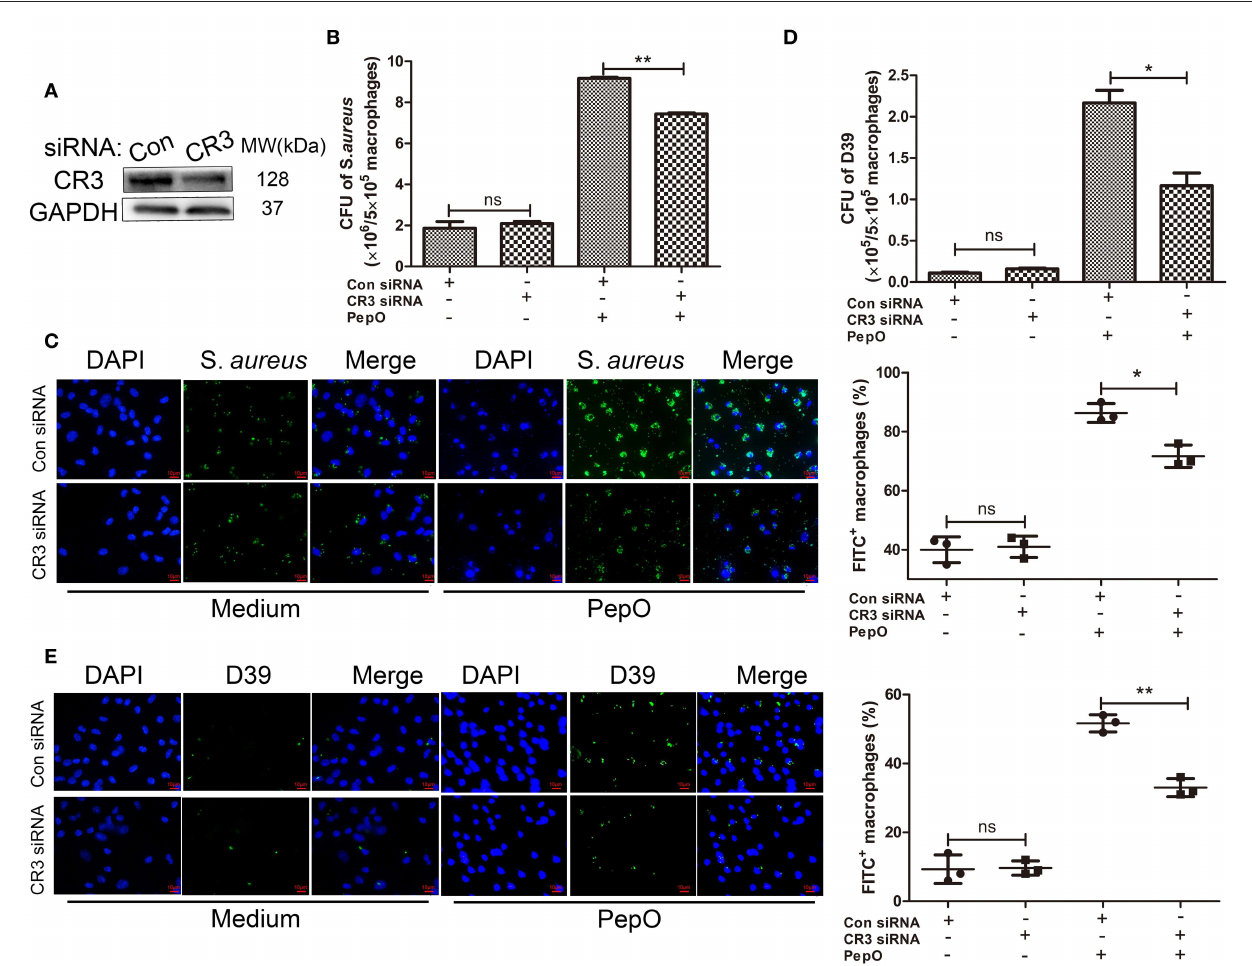
FIGURE 2 | The up regulation of CR3 mediates the enhanced phagocytosis of S. aureus and S. pneumoniae by PepO-stimulated macrophages. (A) Immunoblot showed the effective knockdown of CR3 in PEMs. (B,D) PEMs were transfected with CR3 siRNA or scrambled siRNA for 24h followed by PepO stimulation for another 24h and infection of S. aureus (B) or D39 (D) for 30min. The number of phagocytosed bacteria was determined. Data are shown as averaged ( ± SD) bacterial number of three independent repeated experiments. (C,E) PEMs were treated as described in (B) and infected with FITC-labeled S. aureus (C) or FITC-labeled D39 (E) for 30min. Representative pictures (original magnification, × 40) from one of the three experiments are shown. The quantification is shown as averaged ( ± SD) percent of FITC + macrophages from three independent repeated experiments. Scale bar, 10 µ m. Statistical analysis was performed by two-way ANOVA test. ** p < 0.01, * p < 0.05, ns, not significant; Con,